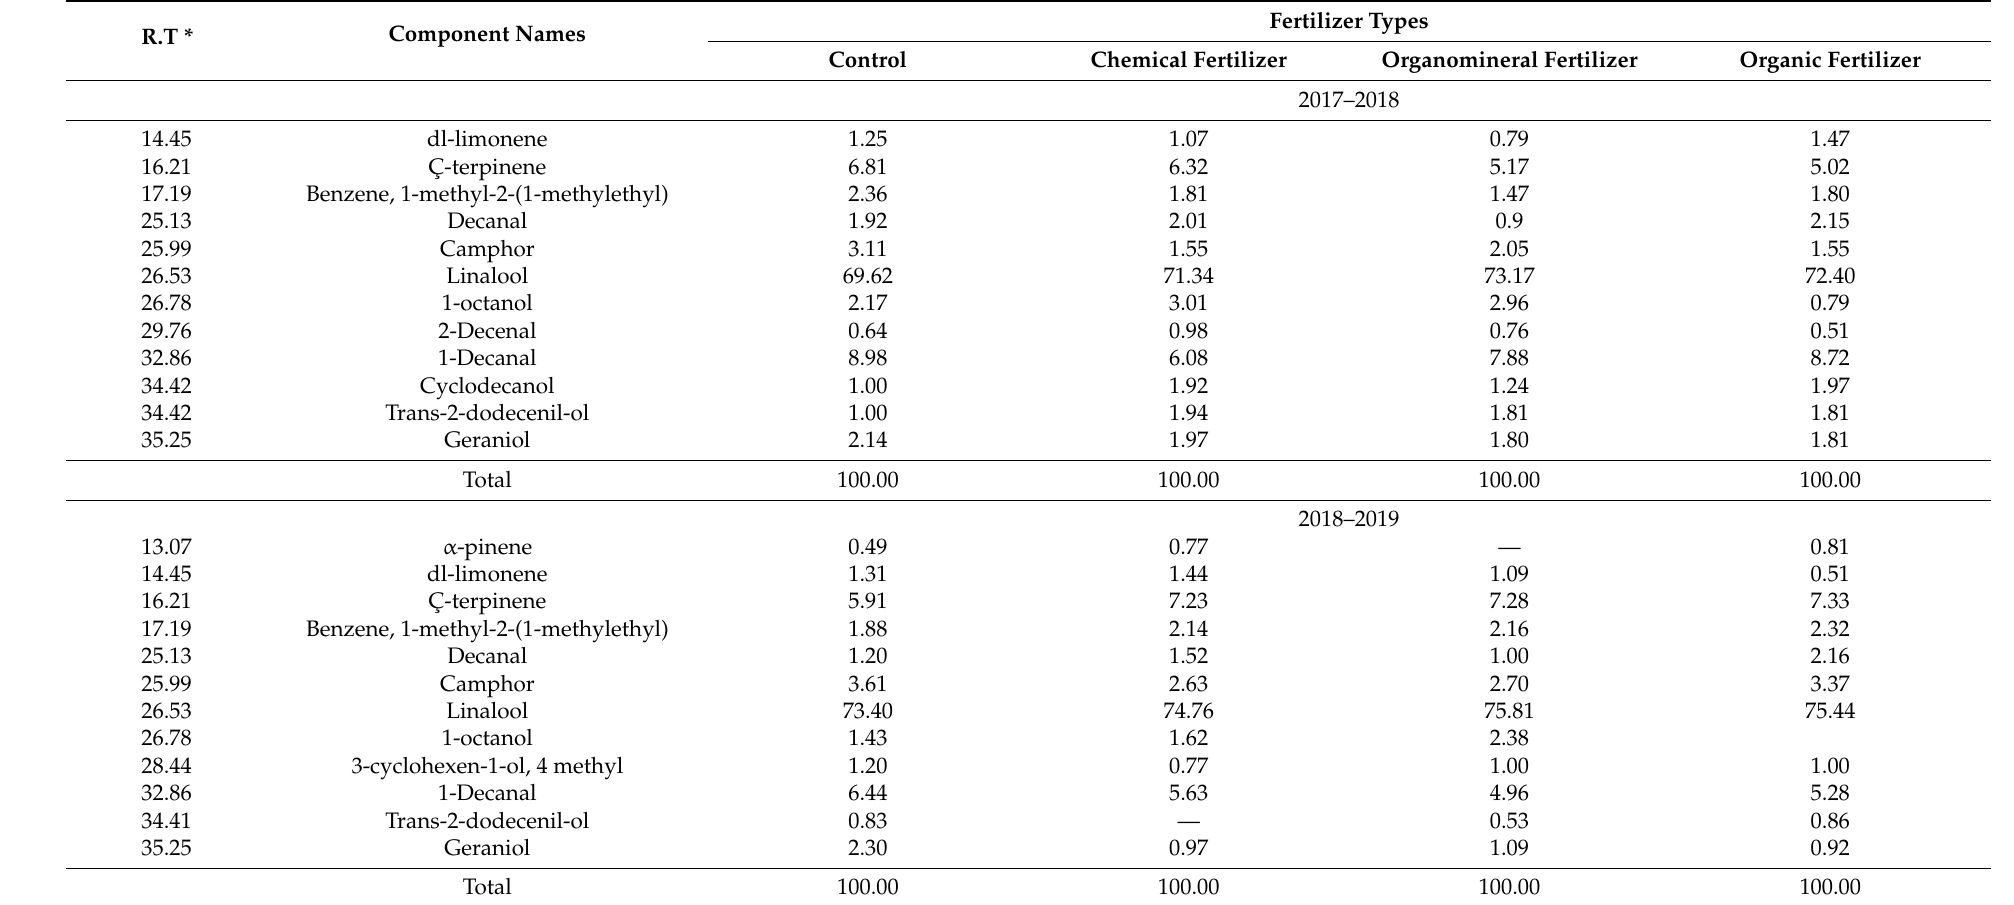
Table 11. Essential oil components of Arslan coriander variety